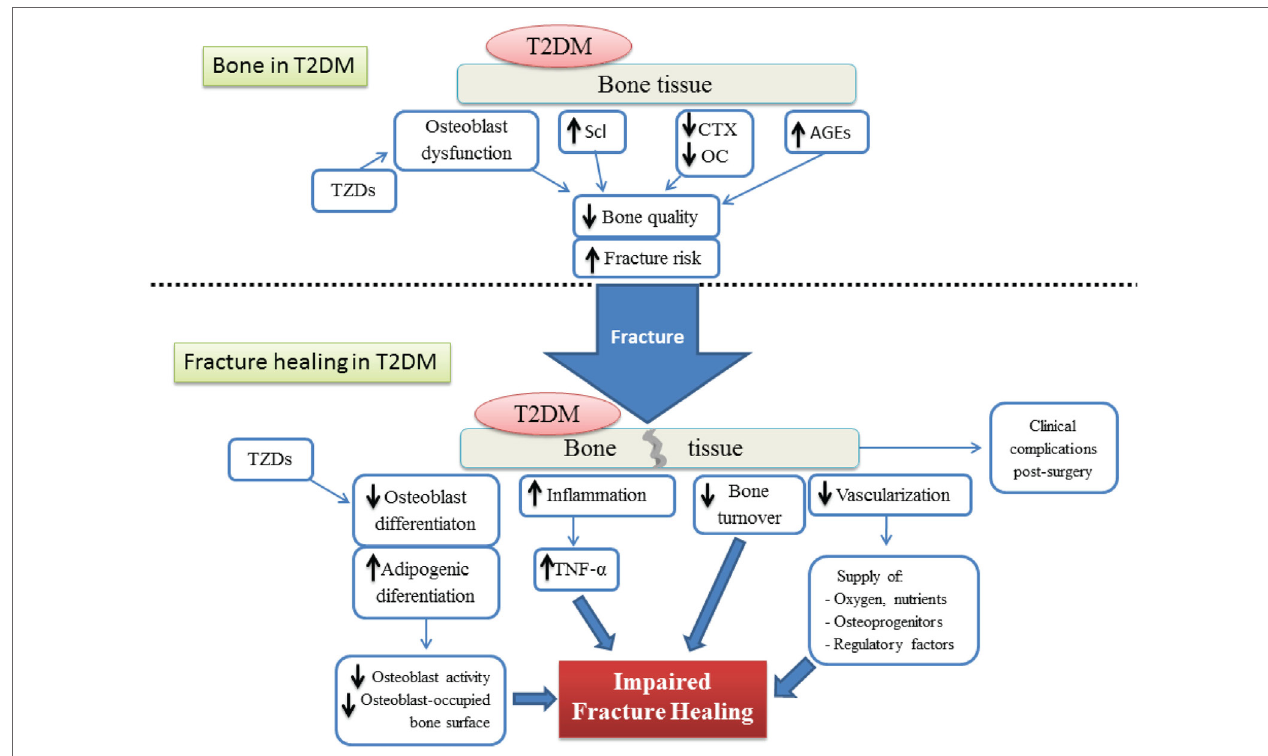
FigURe 5 | Schematic representation of both the bone tissue state and the different factors involved in the impairment of the fracture healing process, under type 2 diabetes conditions. T2DM, type 2 diabetes mellitus; AGEs, advanced glycation end products; TZDs, thiazolidinediones; Scl, sclerostin; CTX, terminal cross-linked telopeptide of type-I collagen; OC, osteocalcin; TNF- α , tumoral necrosis factor